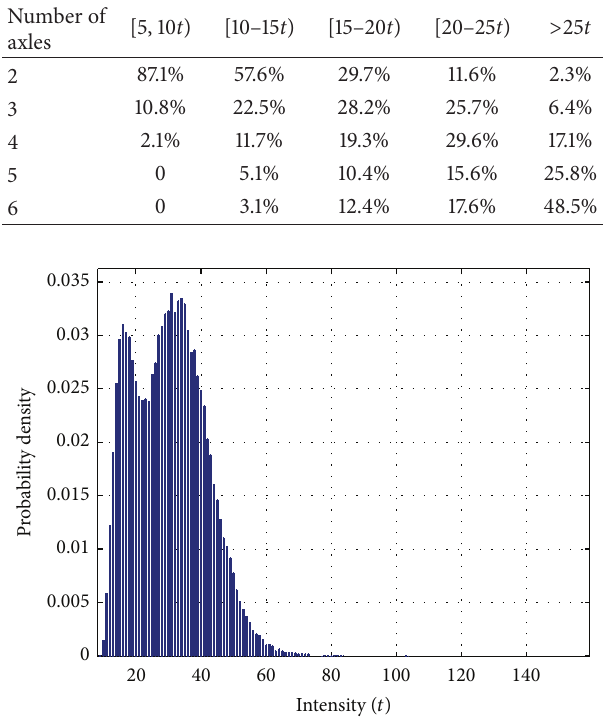
Figure 10: Histogram of five-axle (or more) trucks.